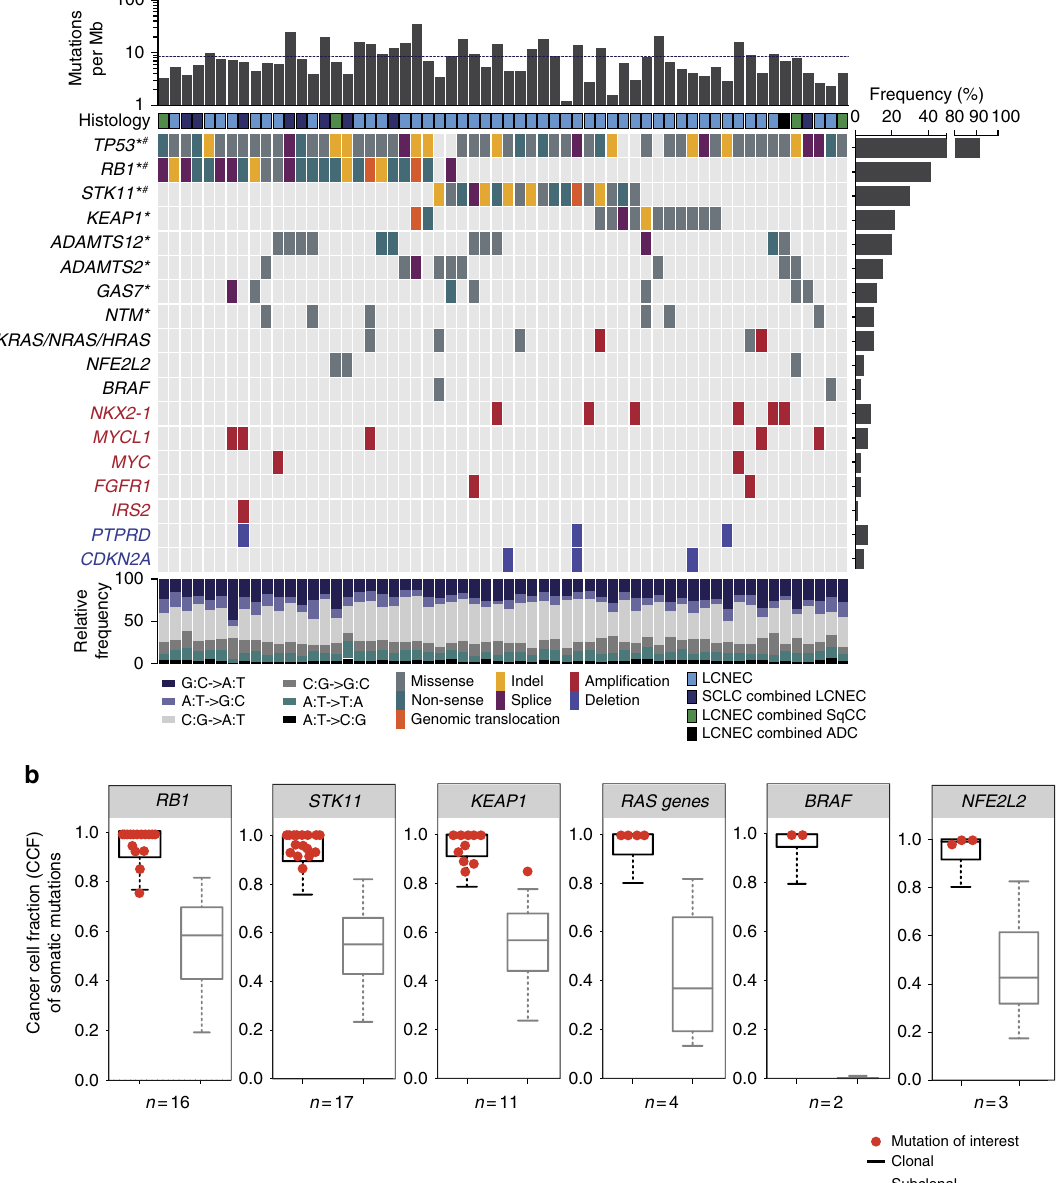
Fig. 1 Genomic alterations in pulmonary large-cell neuroendocrine carcinomas (LCNECs). a Tumor samples are arranged from left to right. Histological assignments and somatic alterations in candidate genes are annotated for each sample according to the color panel below the image. The somatic mutation frequencies for each candidate gene are plotted on the right panel. Mutation rates and the type of base-pair substitutions are displayed in the top and bottom panel, respectively; a dashed black line indicates the average value. Signi fi cantly mutated genes and genes with a signi fi cant enrichment of damaging mutations are denoted with * and #, respectively ( Q < 0.01, Methods section). Genes with signi fi cant copy number (CN) ampli fi cations (CN > 4) and deletions (CN < 1) (Supplementary Fig. 2a, Supplementary Dataset 5) are displayed in red and blue, respectively ( Q < 0.01, Methods section). b The distribution of clonal and sub-clonal mutations was analyzed for tumor samples that harbored mutations in key candidate genes. The cancer cell fractions (CCF) of all mutations were determined, assigned to clonal or sub-clonal fractions (Methods section), and displayed as whiskers box-plot (median and interquartile range, whiskers: 5 – 95 percentile). The CCF of candidate gene mutations is highlighted in